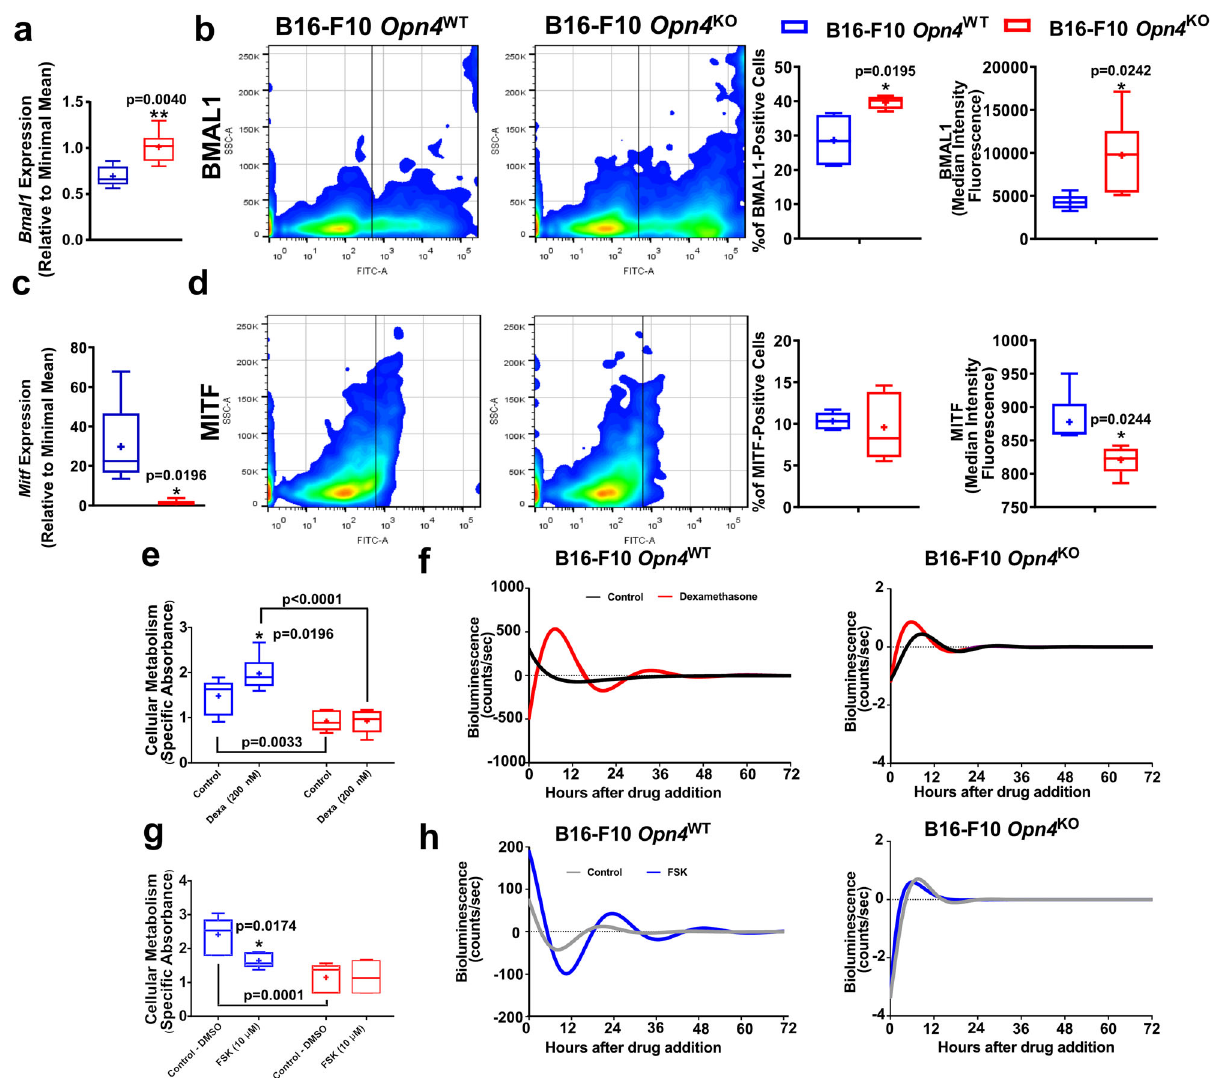
Fig. 3 Reduced growth of Opn4 KO cells in vitro is associated with reduced MITF expression and reduced clock gene activation by classical activators. a – d Bmal1 and Mitf gene and protein evaluation in Opn4 WT and Opn4 KO malignant melanocytes in vitro. Gene expression, BMAL1 and MITF positive cells, median intensity fl uorescence (MIF), and quantitative analyses are depicted. In a , n = 5 and 6 for Opn4 WT and Opn4 KO cells, respectively. In b , n = 4 and 5, respectively. In c , n = 5 and 6, respectively. In d , n = 5 for each group. e – h Cellular metabolism assessment by XTT assay in response to classical clock activators and molecular clock evaluation by bioluminescence assay ( Per1 :Luc) of Opn4 WT and Opn4 KO malignant melanocytes. In e , n = 6 and 11, respectively; in f , n = 4 and 11, respectively. In g , n = 6 for both groups. In h , n = 6 and 9, respectively. In every analyzes, the n number is derived from independent